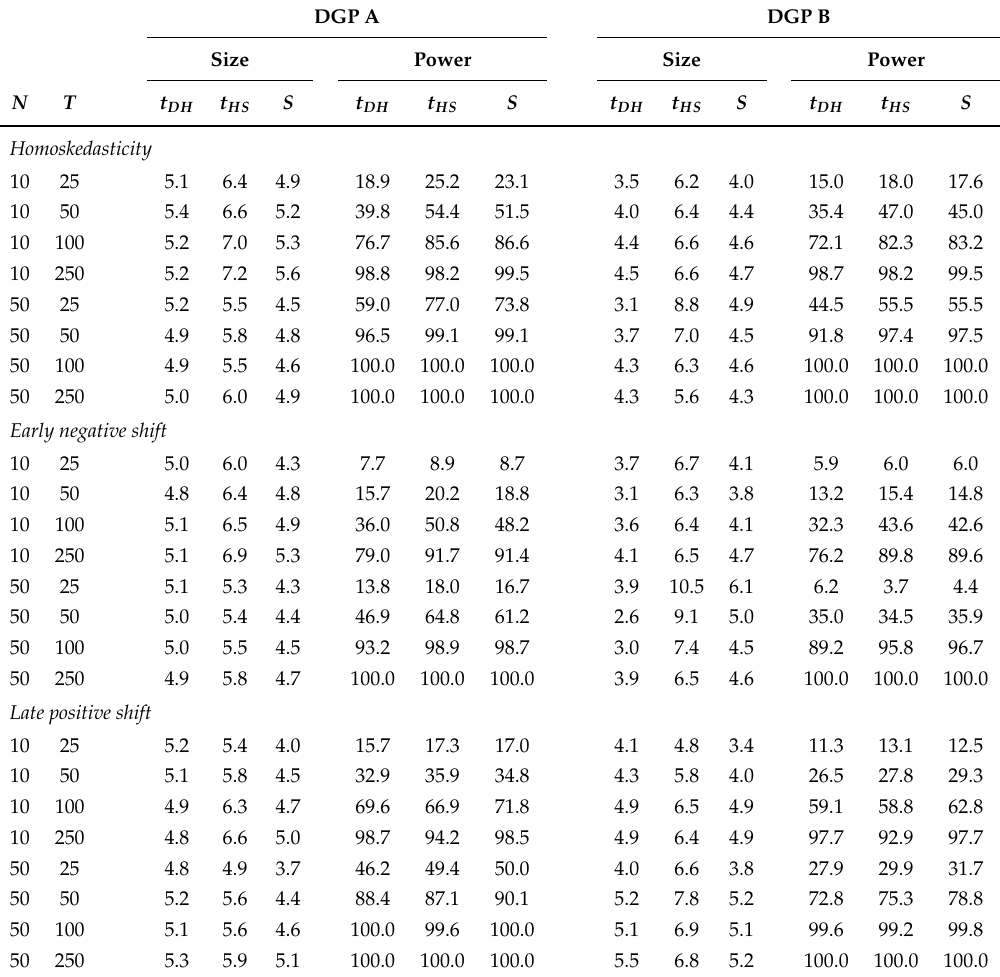
Rejection frequencies in cross-sectionally independent panels. γ i ∼ iid U ( 0.9,1 ) , µ i ∼ iid U ( 0,0.02 ) . DGP B: θ i ∼ iid U ( 0.2,0.4 ) . Power is computed using size-adjusted 5%